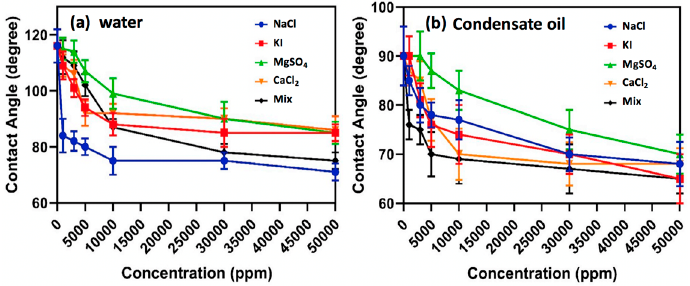
Figure 9. Impact of salinity on the performance of fluoropolymer. Reprinted with permission from [110], copyright © 2019 Elsevier B.V.